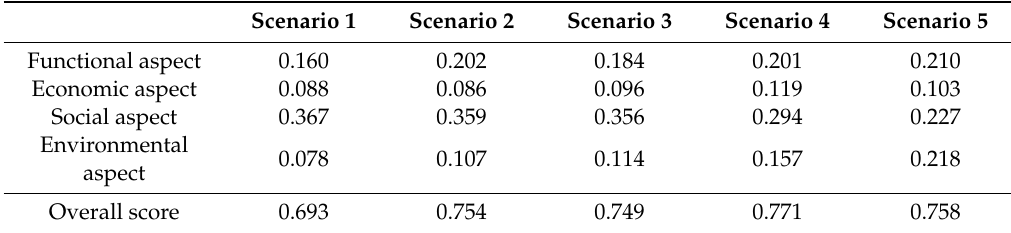
Table 13. Comprehensive results based on multi-attribute utility theory